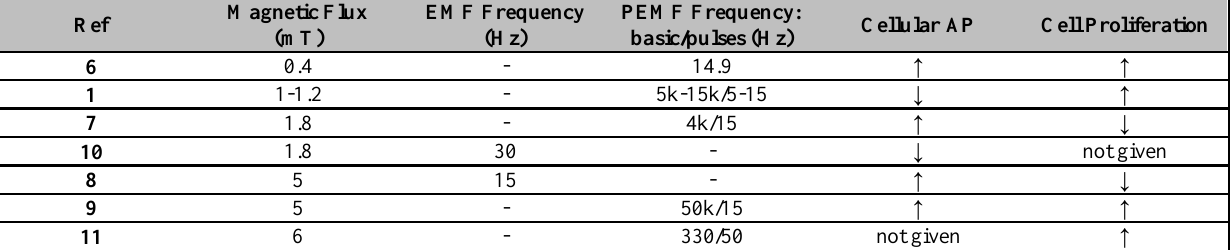
Table 1. Synopsis of the published data on the response of cultured osteoblasts to alternating electromagnetic field